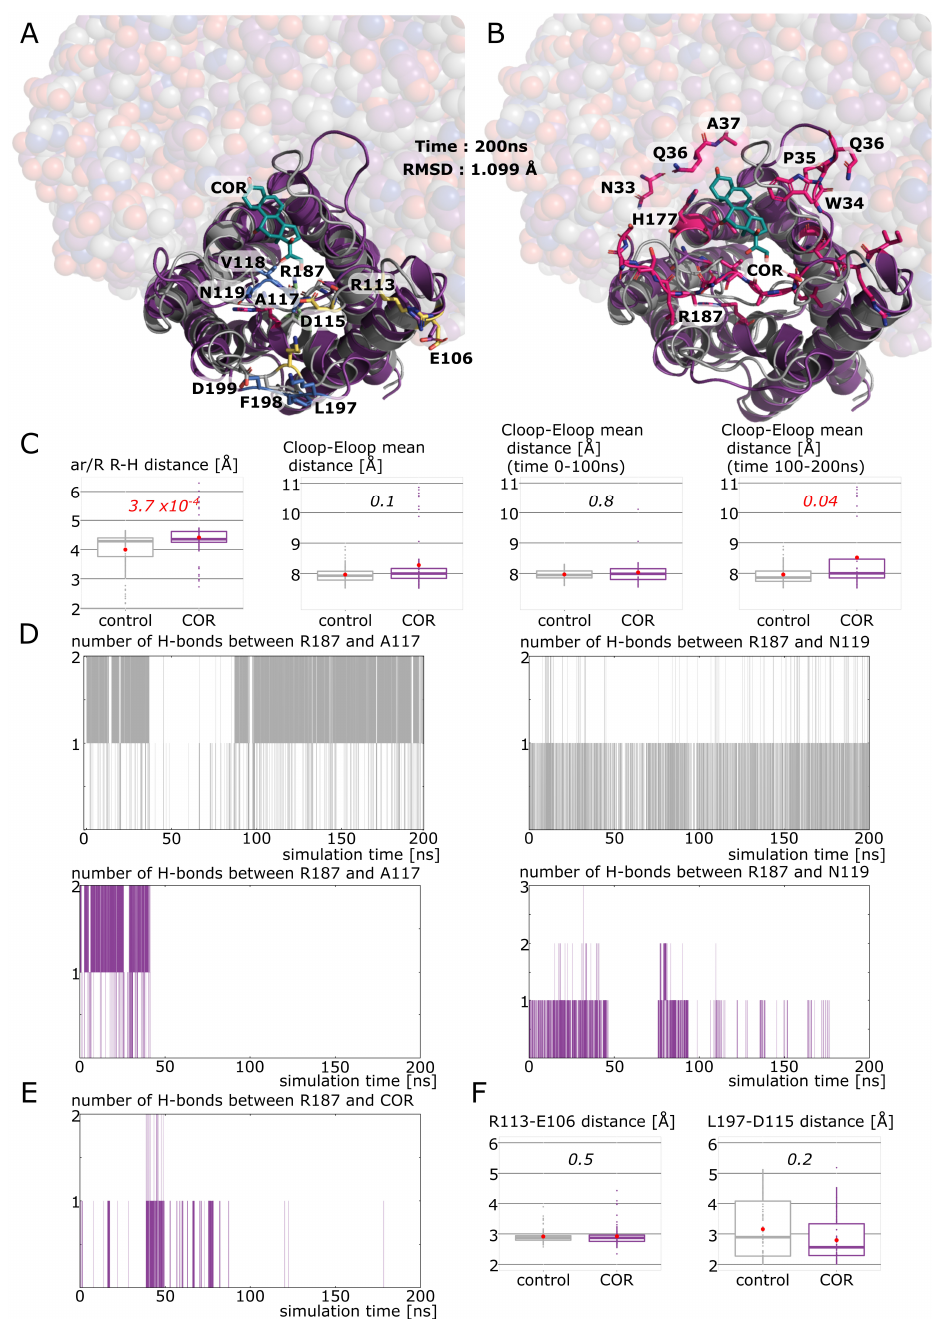
Figure 4. New insights on extra-cellular C-loop regulatory function. ( A , B ) Representation of AQP2 chain A at time = 200 ns. The three other chains are represented with spheres. “Control” condition is colored in gray and “COR” condition in purple. Cortisol in interaction with chain A is represented in green. ( A ) Arginine of the ar/R constriction is colored in green in “control” and in pink in “COR”. Residues used for C-loop–E-loop mean distance calculations are colored in blue, and residues used for R113–E106 and L197–D115 smallest distance calculations are colored in yellow. ( B ) All residues establishing hydrogen bonds with the cortisol in “COR” during the 200 ns of simulation are colored in pink. ( C ) From left to right: smallest distance between the arginine and the histidine of the ar/R constriction; C-loop–E-loop mean distance (alpha carbon of residues colored in blue in A are used) over the entire trajectory; C-loop–E-loop mean distance over the first half of the trajectory (0 ns to 100 ns) and over the second half of the trajectory (100 ns to 200 ns). Conditions were compared with non-parametric Mann–Whitney test and p values are indicated in italic. ( D ) Number of